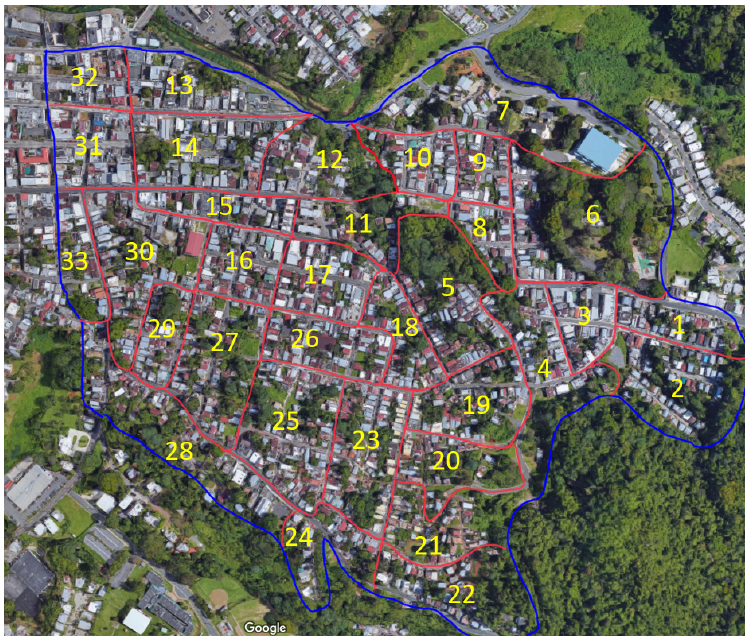
Figure 2. Thirty-three sections of the La Salud